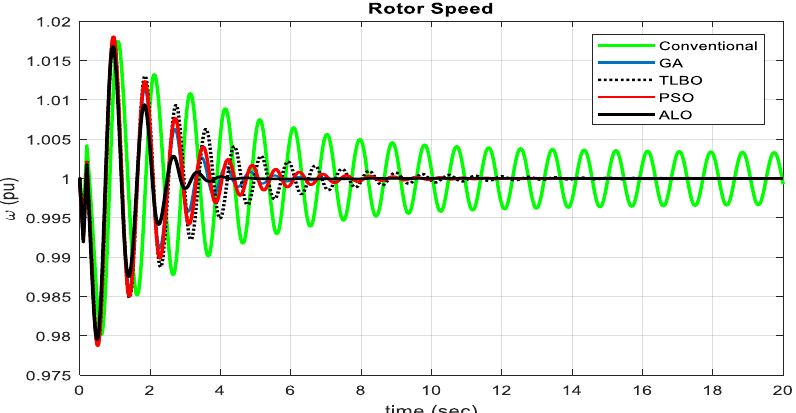
Figure 12. Rotor speed of different algorithms with the conventional fixed gain model . Table 9. Maximum overshoot and settling time of power system parameters .